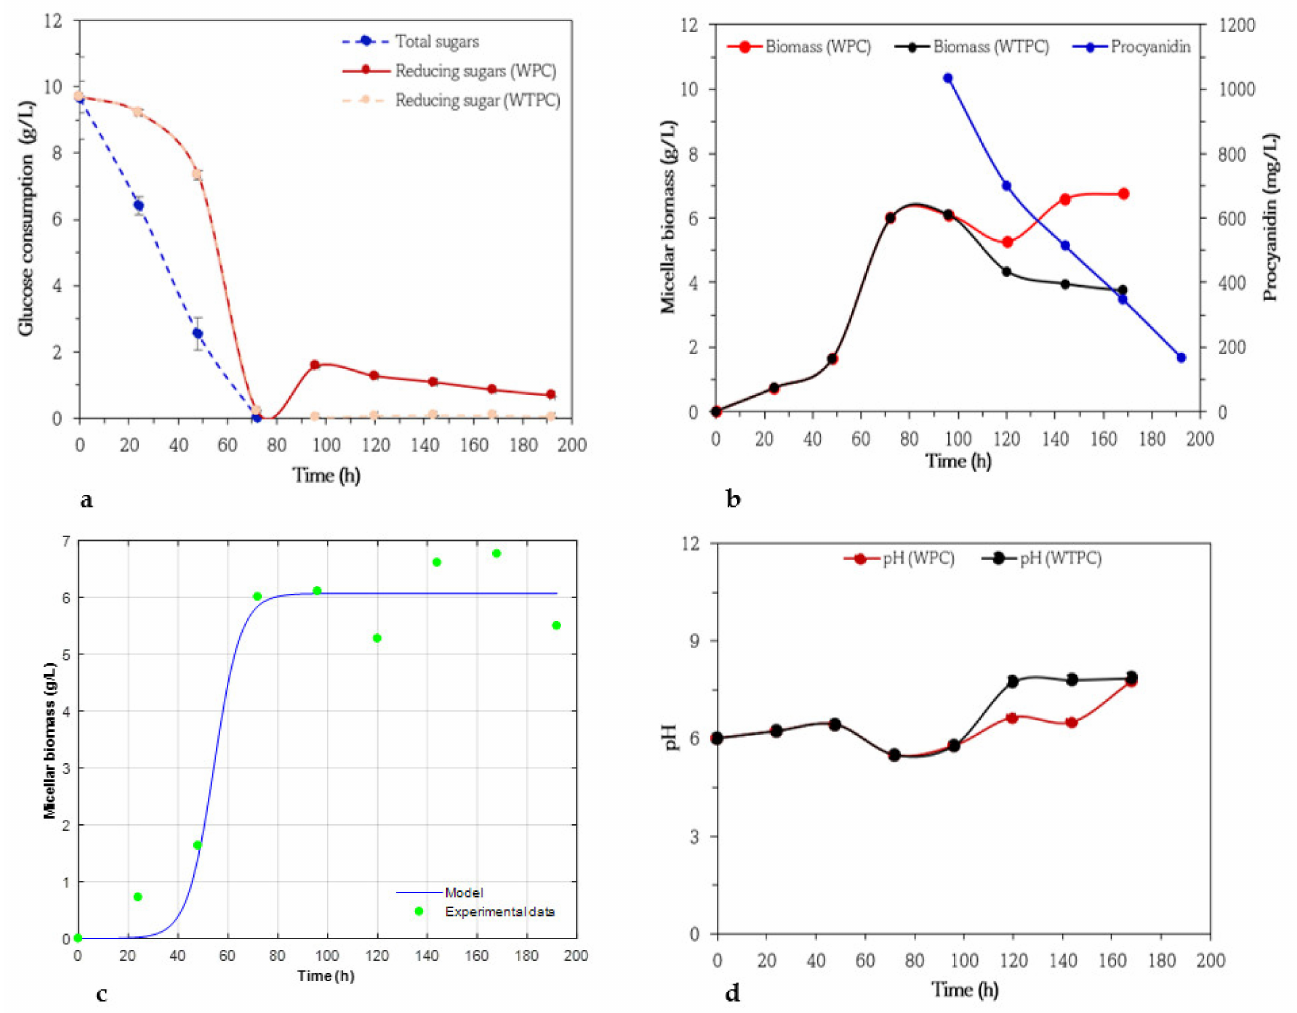
Figure 5. Variation in glucose concentrations by anthrone and 3,5 dinitrosalicylic acid (DNS) methods ( a ), micellar biomass in culture medium with (WPC) and without addition of procyanidins (WTPC) when glucose was below 3.0 g/L (stationary phase), and changes in procyanidin concentrations ( b ) in submerged cultures of Trichoderma harzianum. Micellar biomass production by Trichoderma harzianum in submerged cultures using basic medium of salts and glucose (10 g/L) and with addition of procyanidin when glucose was below 3.0 g/L (stationary phase). Symbols represent experimental data. Solid lines represent calculated data ( c ), Evolution of pH in submerged cultures of Trichoderma harzianum in medium with (WPC) and without (WTPC) addition of procyanidins when glucose was below 3.0 g/L (stationary phase) ( d